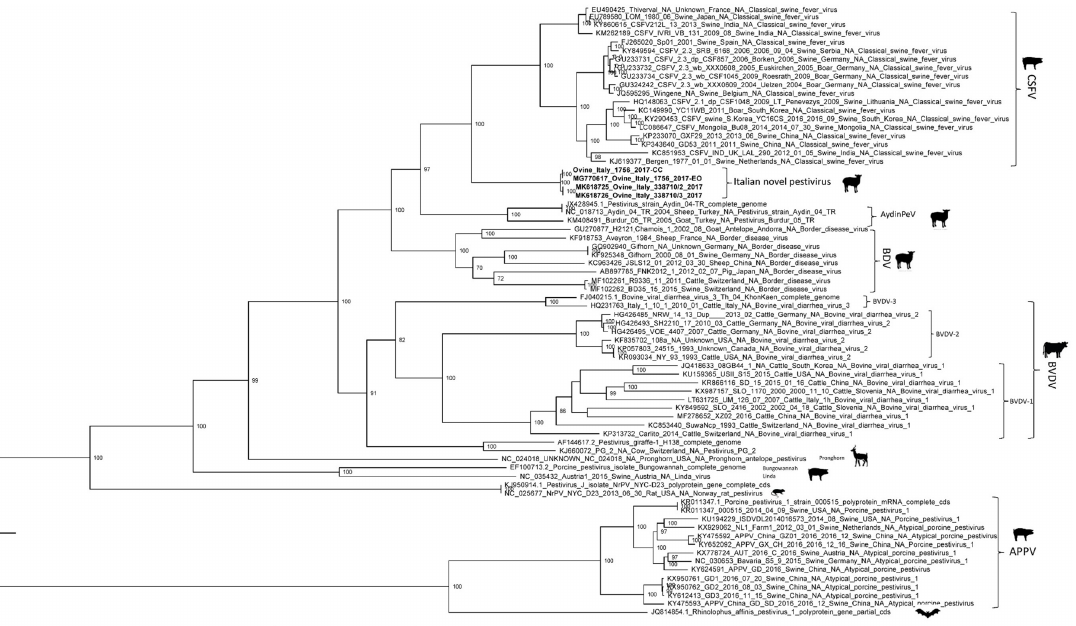
Figure 2. Maximum Likelihood phylogenetic tree, based on the complete genomes of both the EO and CC sequences of Ovine / IT / 1756 / 2017, Ovine / IT / 338710-2 / 2017, and Ovine / IT / 338710-3 / 2017 (in bold) and 68 other pestivirus sequences. The best-fit model according to BIC was HKY85. The data of pestivirus isolates shown in the phylogenetic tree consisted of GenBank Accession No., viral name, country, and date of